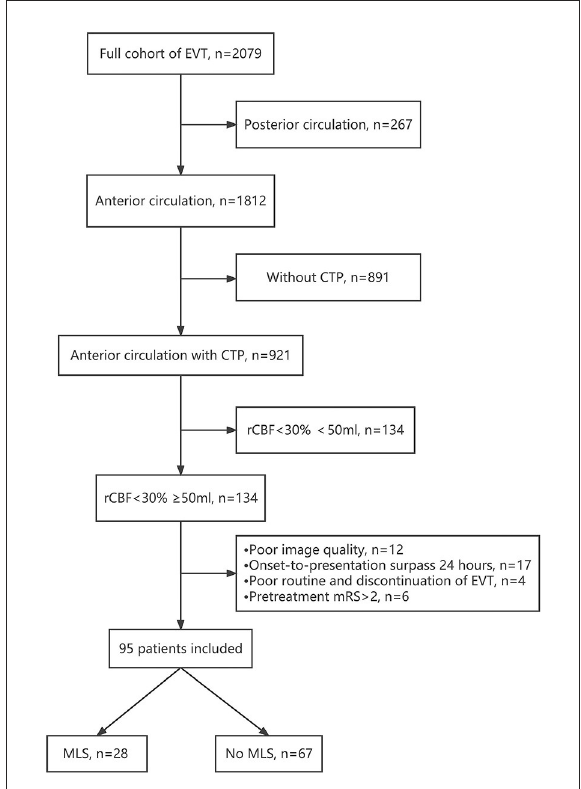
FIGURE1 Study flow chart. CTP, CT perfusion; EVT, endovascular Therapy; MLS, midline